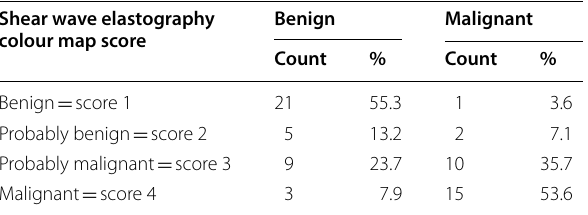
Table 1 The distribution of the SWE score in relation to the final pathology Shear wave elastography colour map score